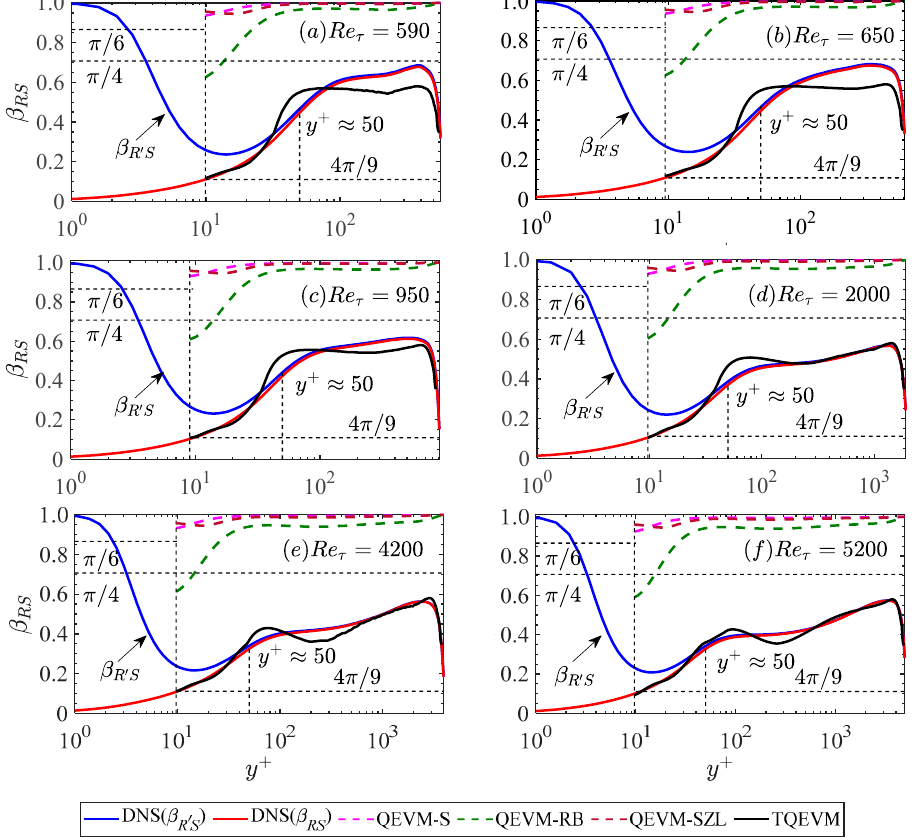
Figure 9. Alignment indicators β RS ( y + ) for ( a ) Re τ = 590, ( b ) Re τ = 650, ( c ) Re τ = 950, ( d ) Re τ = 2000, ( e ) Re τ = 4200, and ( f ) Re τ = 5200 obtained from DNS, QEVM-S, QEVM-RB, QEVM-SZL, and the proposed TQEVM. Note that β R (cid:48) S ( y + ) to represent the alignment trend between the total stress and mean strain tensors are defined similarly.